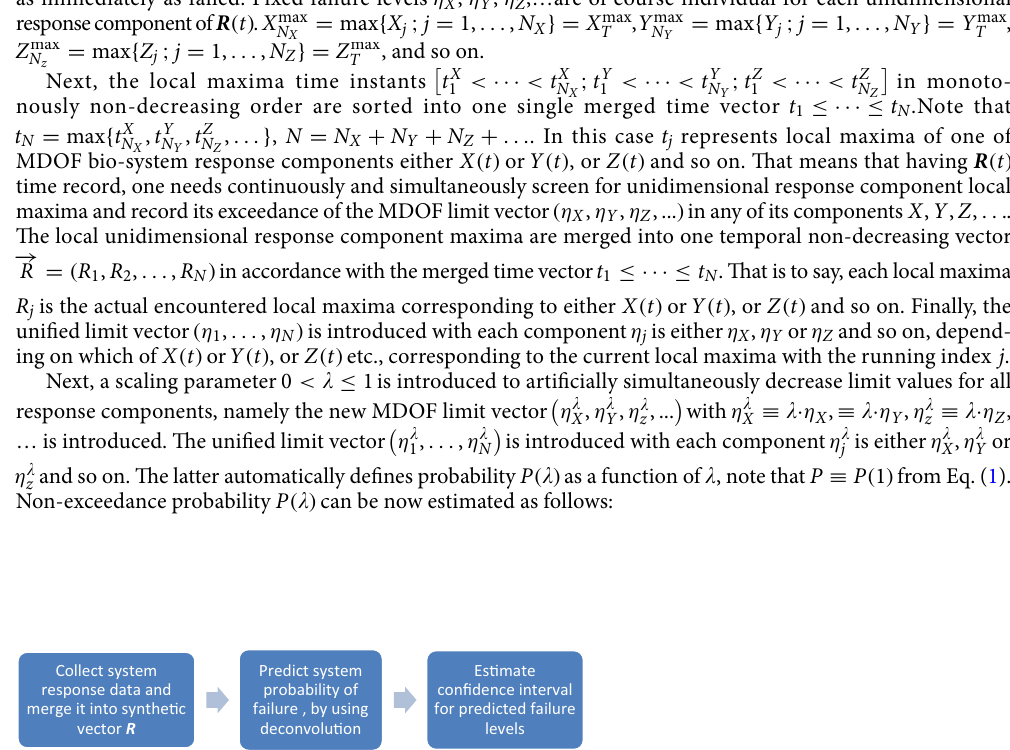
Figure 1. Flow chart for described